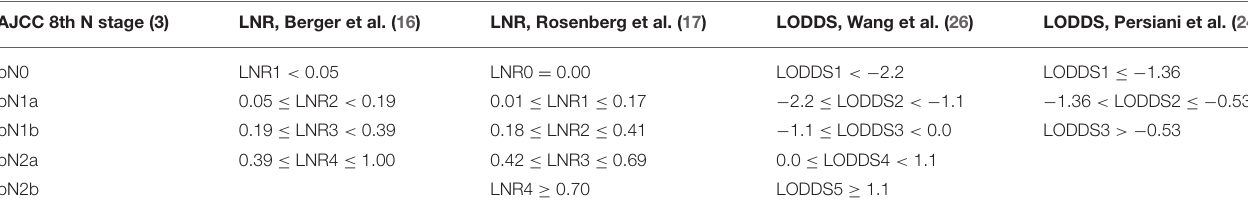
TABLE 1 | Basic characteristics of different lymph node staging